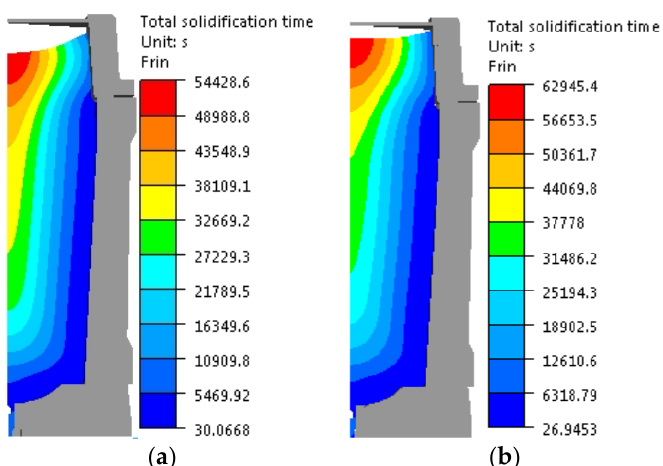
Figure 10. Total solidification time (s) for simulations based on microsegregation models of ( a ) lever rule; ( b ) Scheil.